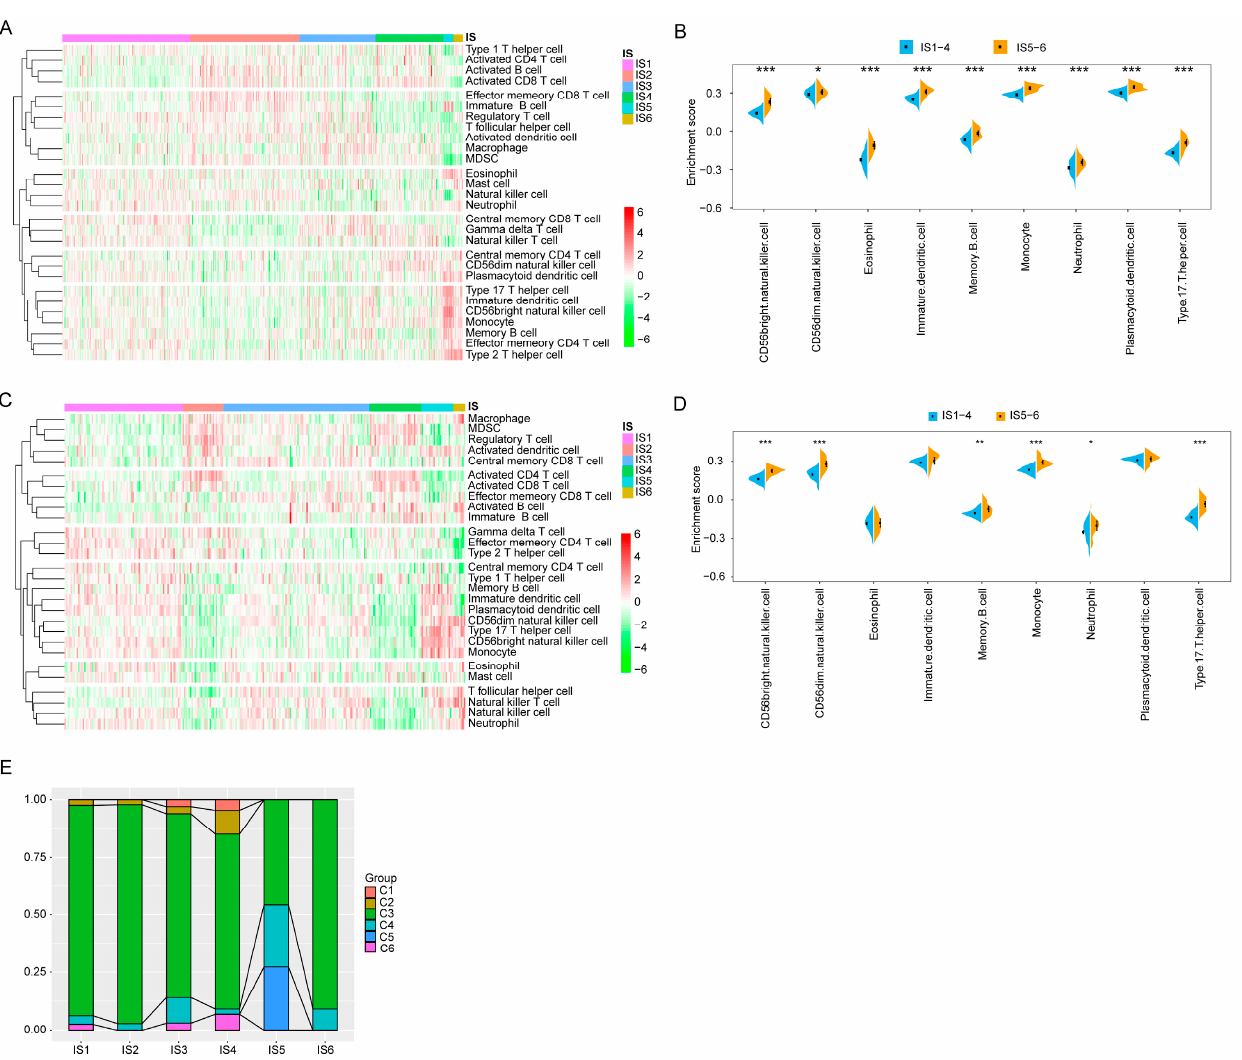
Figure 8. Cellular and molecular characterisation of tumour immune subtypes. In the TCGA ( A ) and GEO ( C ) cohorts, 28 immune cell signatures were differentially enriched in KIRC immune subtypes. Differential enrichment scores of 28 immune cell signatures in the TCGA ( B ) and GEO ( D ) cohort. ( E ) Proportion of overlap between the KIRC immune subtypes and the six pan-cancer immune subtypes. The Cancer Genome Atlas (TCGA); Gene Expression Omnibus (GEO); Kidney renal clear cell carcinoma (KIRC). (* p < 0.05, ** p < 0.01, *** p < 0.001).